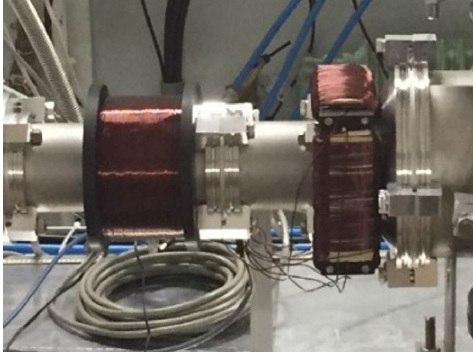
Fig. 8. The electron beam optics